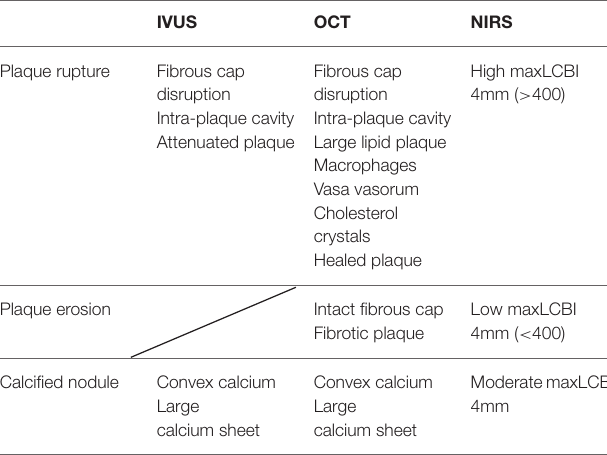
TABLE 1 | Diagnostic criteria for plaque rupture, erosion, and calcified